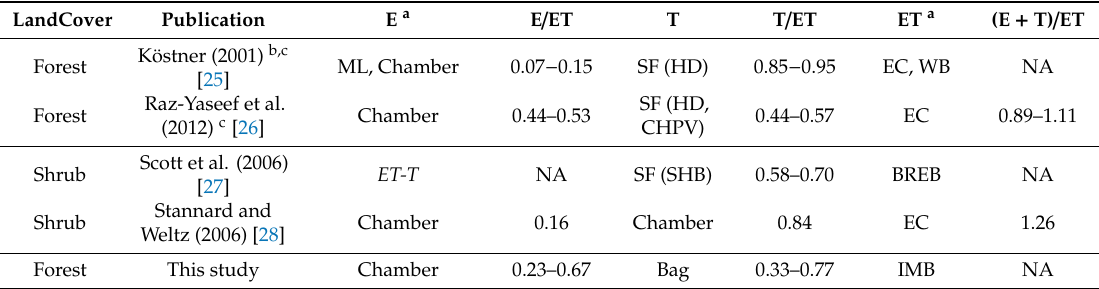
Table 4. Overview of publications regarding evapotranspiration (ET) partitioning (ET = E + T) with measurements for at least two